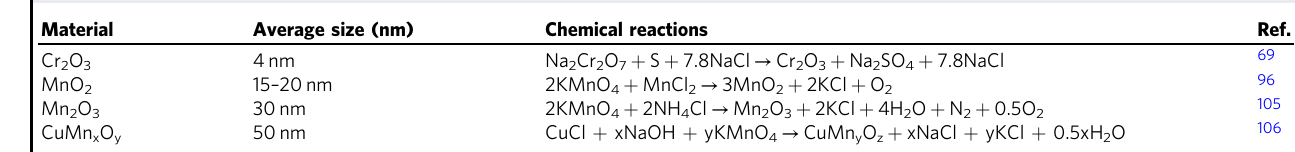
Table 1 Metal-oxide nanoparticles produced via mechanochemically induced redox reactions.